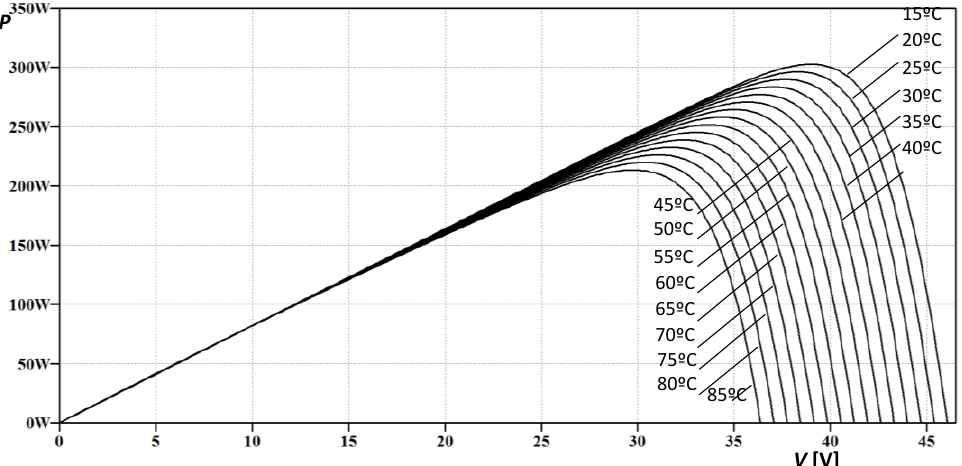
, V , P , and V as a function of sc oc mp mp